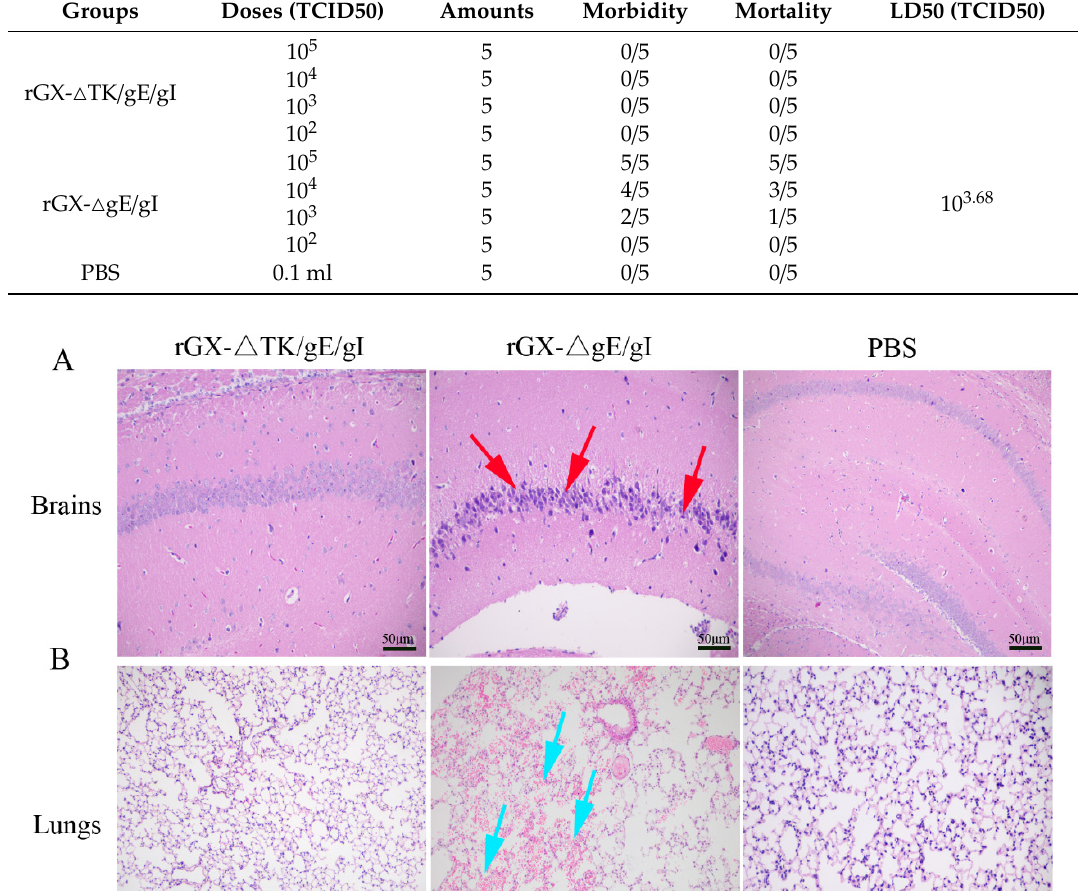
Table 2. Outcome of infection with rGX (cid:52) TK / gE / gI and rGX (cid:52) gE / gI in mice.